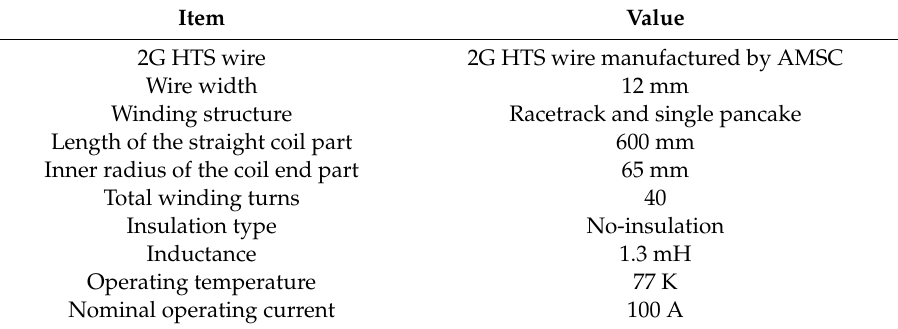
Table 1. Key Parameters of the NI HTS Field Coil.